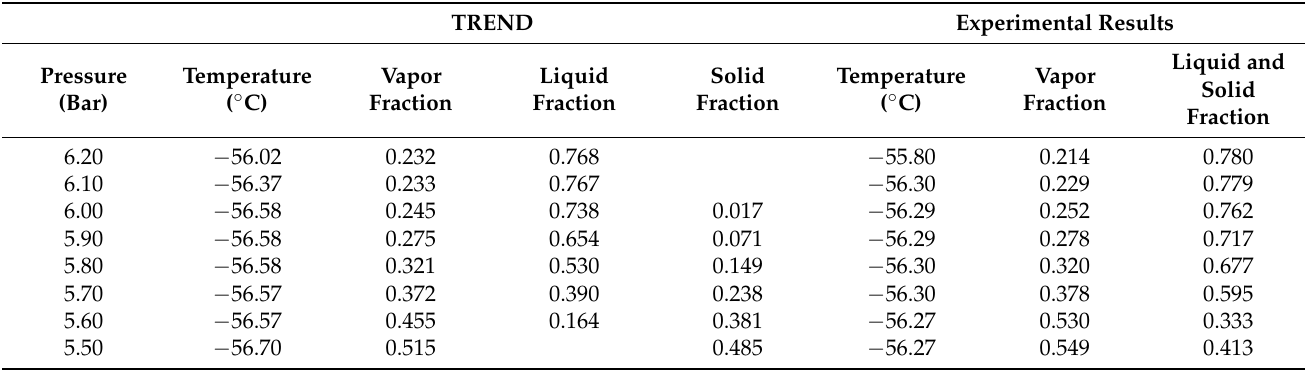
Table 6. Calculated values in TREND and experimental results for vapor, liquid, and gas phase fractions after expansion to the separation pressure in SV02 in Experiment 4.